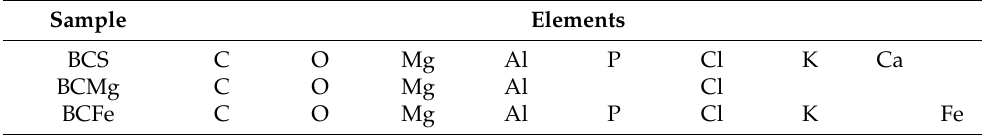
Table 3. Identified elements by energy-dispersive X-ray